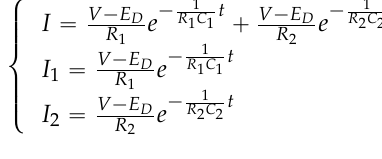
Figure 9. Measured electrodeposition currents and predicted currents by equivalent circuit for different applied potential. The mean absolute differences between measured currents and predicted currents for DC potentials 3.0, 3.2 and 3.4 V are 0.1776, 0.3037 and 0.5776 A/m 2 , respectively. The results demonstrate that the predicated currents and measured currents match well. Thus, the built equivalent circuit is justified.